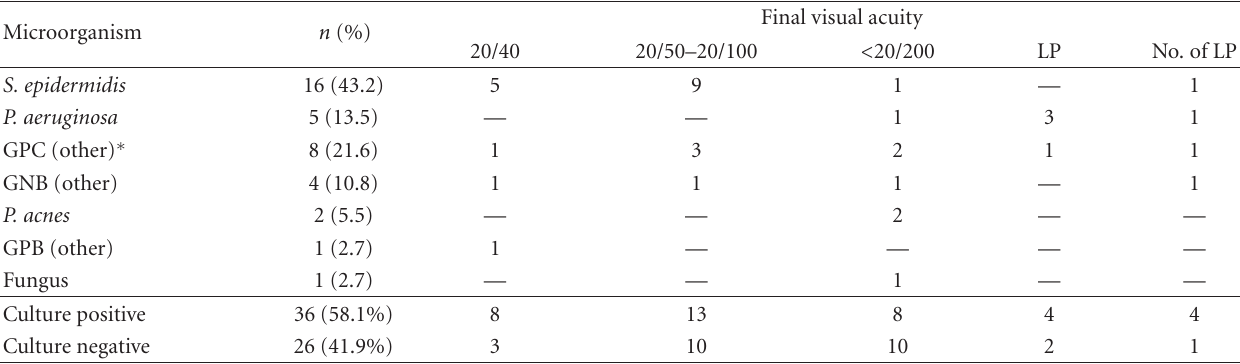
Table 1: The final visual acuity by causative